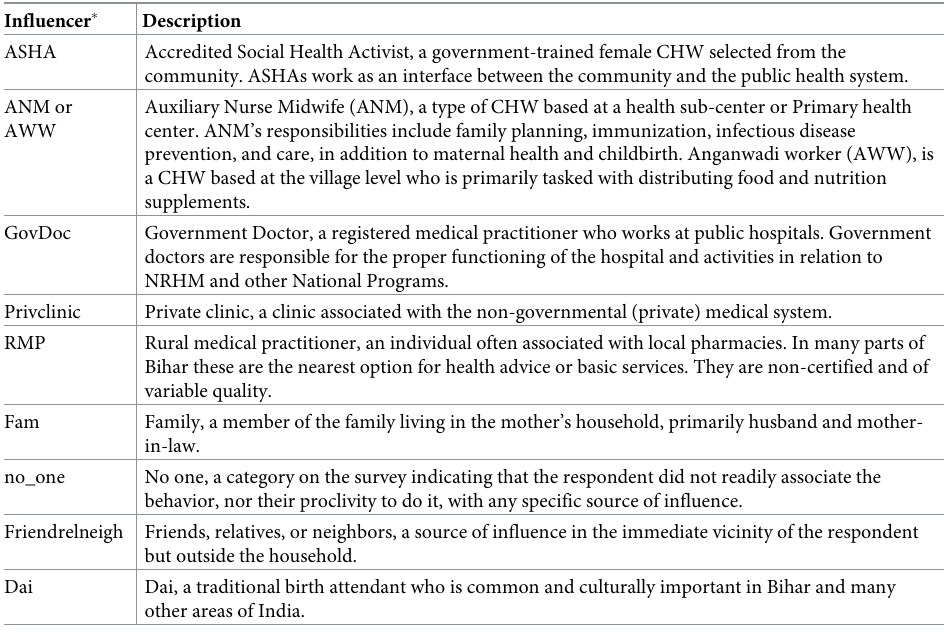
Table 2. Descriptions for each influencer category assessed in the analysis